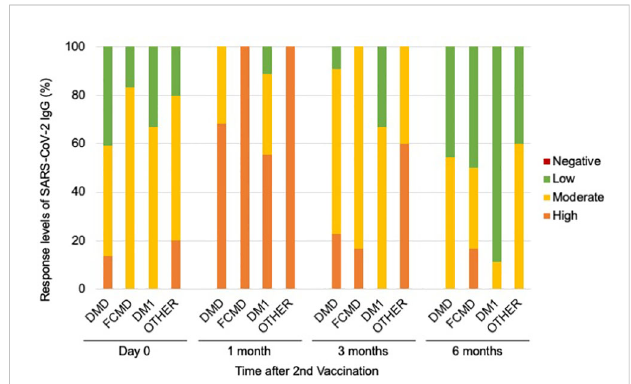
FIGURE 5 Serological response levels of anti-SARS-CoV-2 IgG antibody after second vaccination in each disease types in MDs. DMD subgroup included DMD and DMD-carrier, and other subgroup including MTM, DMRV, LGMD, and